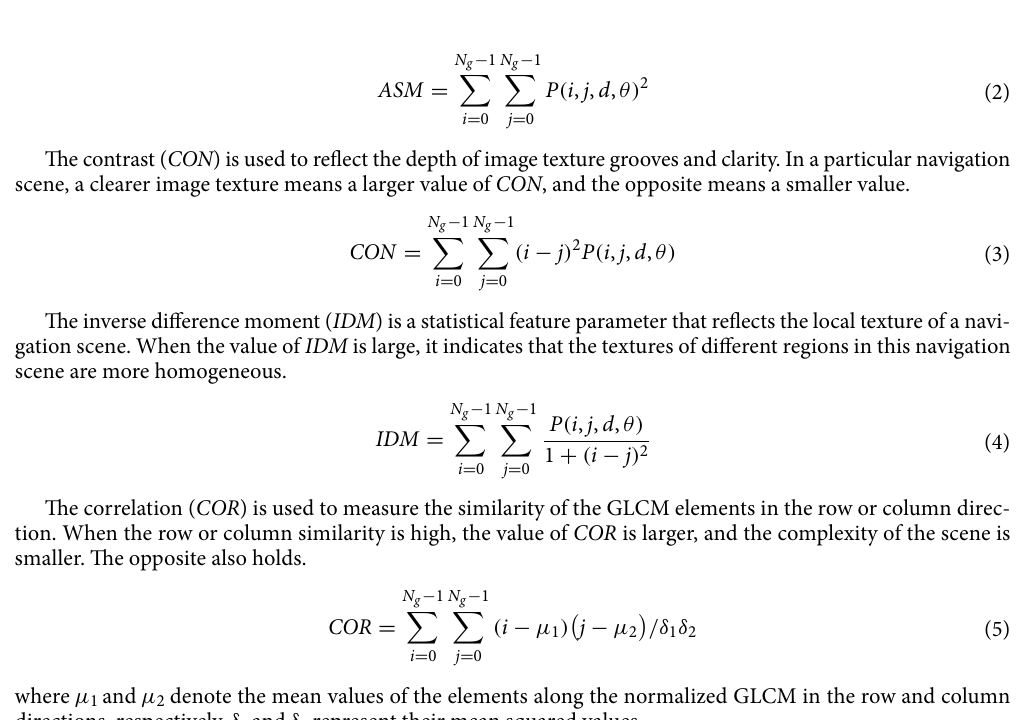
Figure 4. Coarseness of water